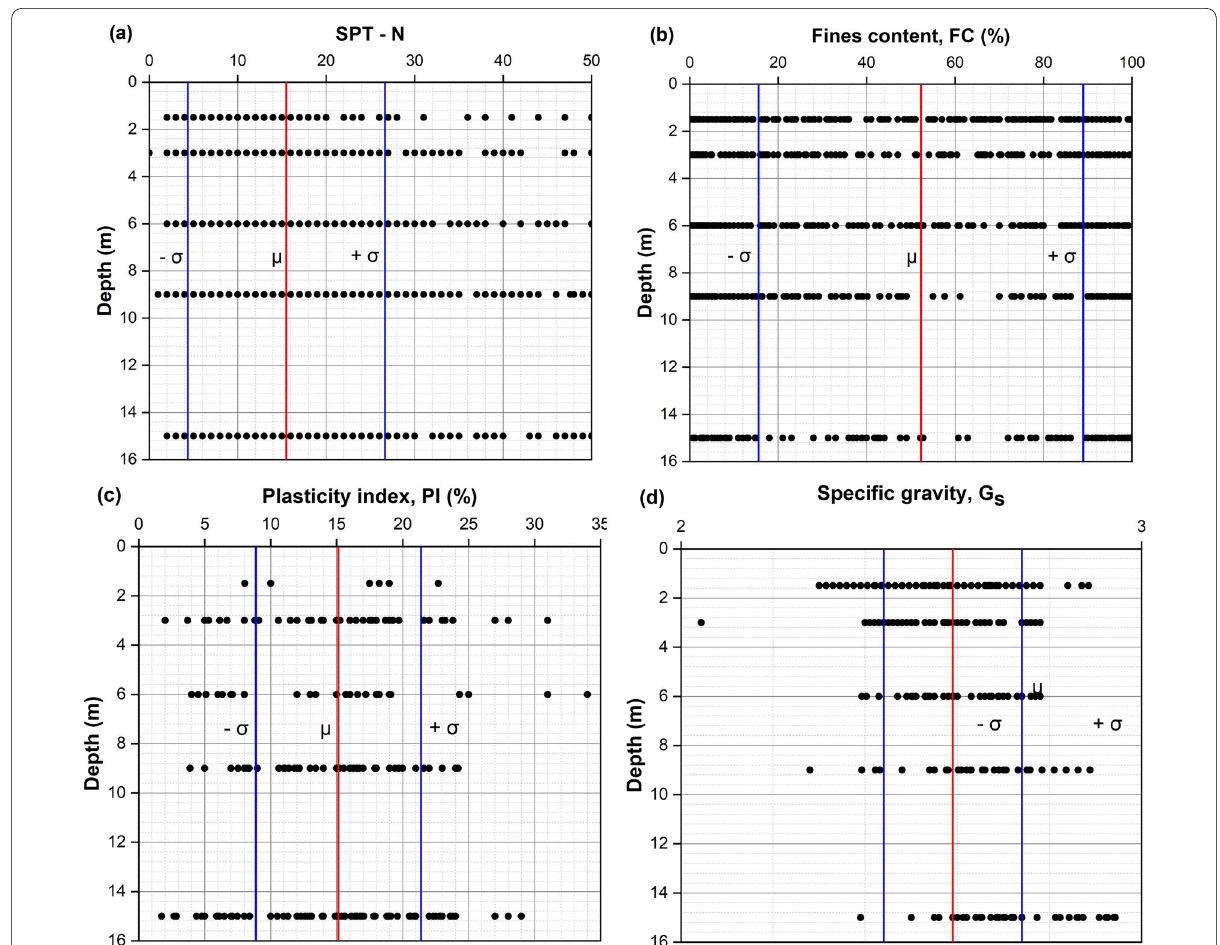
Fig. 4 Depthwise distribution of a SPT-N, b fines content (FC), c plasticity index (PI), and d specific gravity ( G S ) showing mean ( μ ) and standard deviation ( σ ) of the